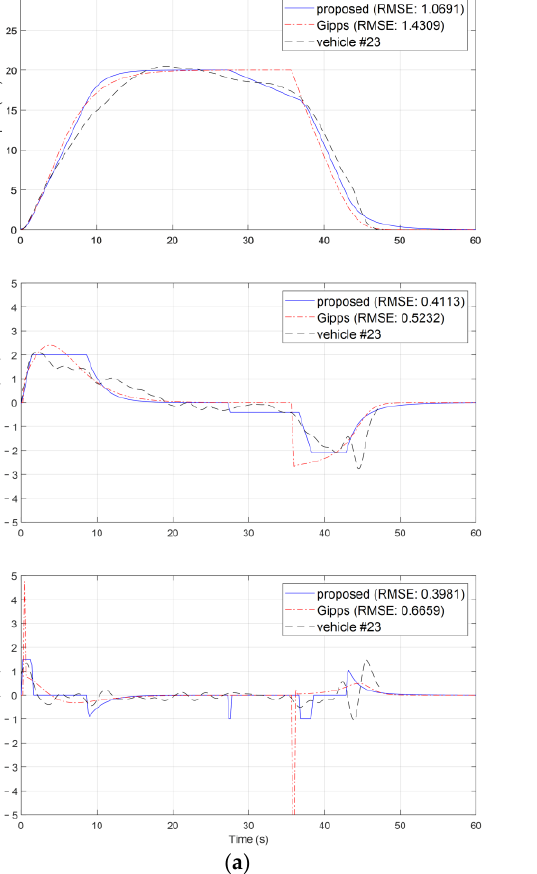
Figure 10. Computer simulation results to compare the Gipps model (compared) and the proposed driver model (proposed): ( a ) the case of SPMD driver #23; ( b ) the case of SPMD driver #57.